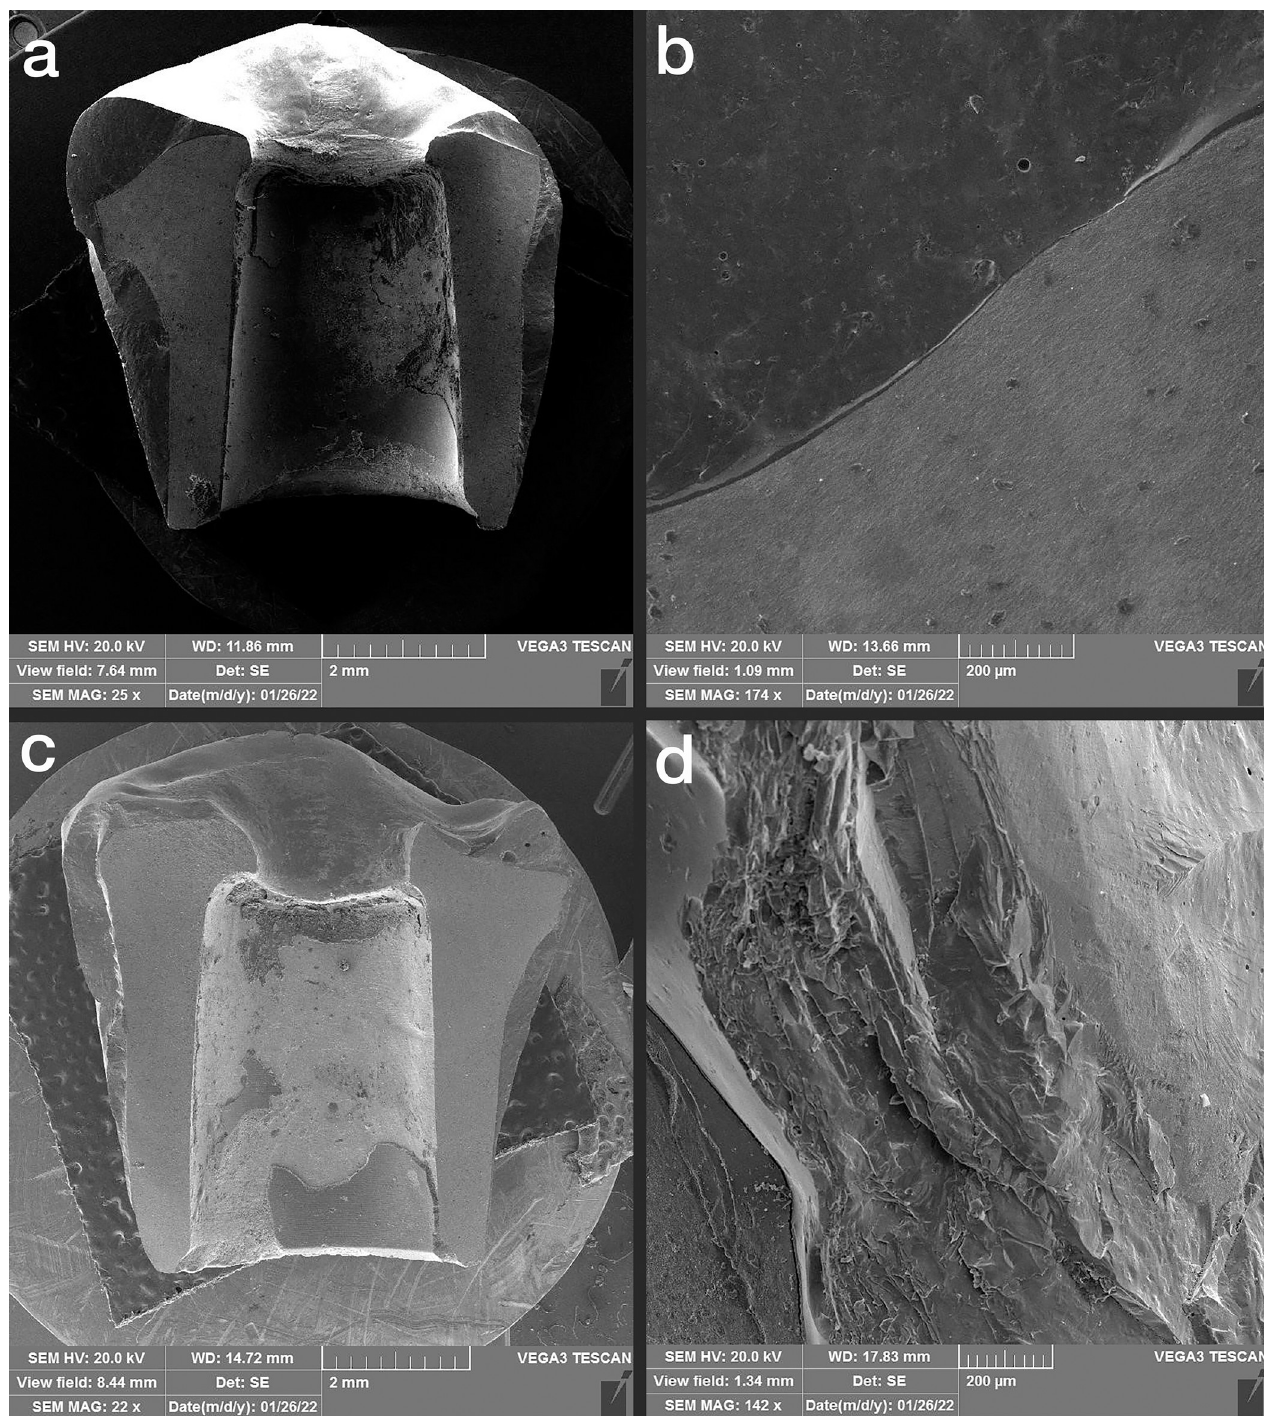
Fig 6. SEM images of porcelain-veneered zirconia specimen. a and b: thermocycled, c and d: non-thermocycled.